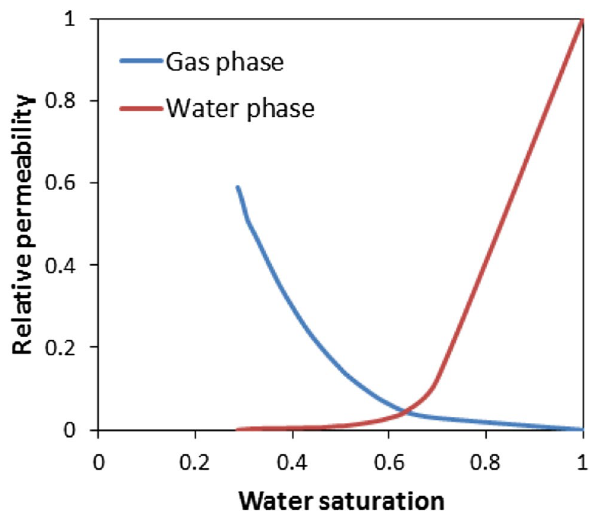
Fig. 1 Normalized relative permeability